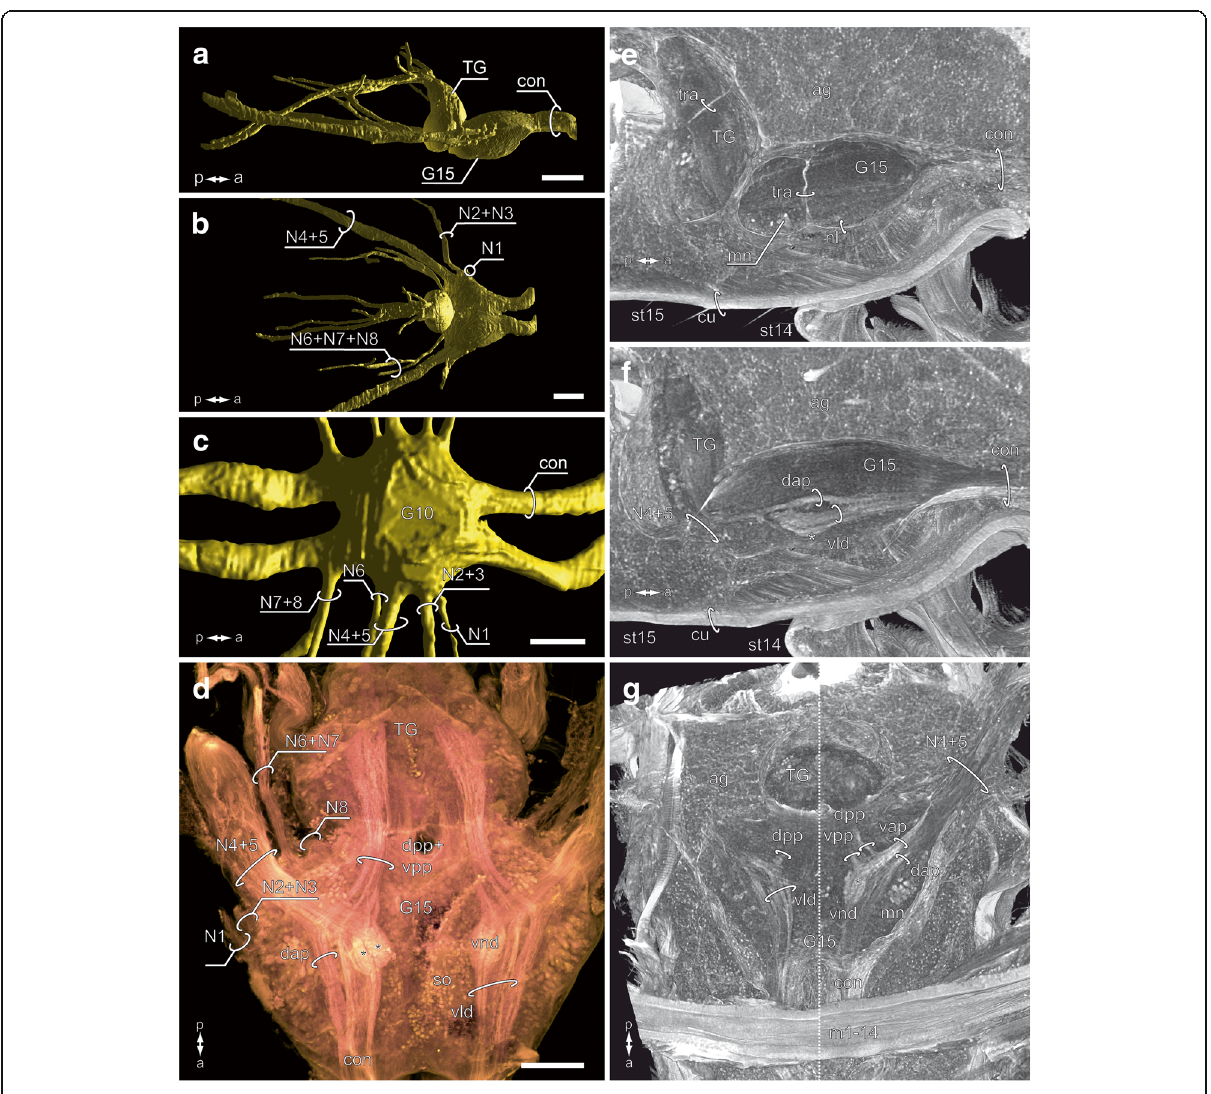
Fig. 8 Morphology and anatomy of the ultimate leg-associated ganglion (G15). a , b 3D reconstruction of G15, the terminal ganglion, and associated nerves. MicroCT analysis, lateral and dorsal views. Note the posteriad directed nerves. Scale bars 200 μ m. c 3D reconstruction of walking leg-associated ganglion 10, based on microCT analysis, dorsal view (modified after [18]). Note the laterad projecting nerves. Scale bar 200 μ m. d Autofluorescence preparation of G15 and terminal ganglion. cLSM maximum projection of the ventral part of the ganglion. Within the ganglion, leg afferents from nerves N4 and N5 comprise prominent anteriad projections, including the glomeruli of the ventral neuropilar domain (asterisks) and the ventral lamellate domain (vld). Note that projections proceed into the anterior connectives. In addition, posteriad projections (dpp and vpp) proceed into the terminal ganglion. Scale bar 100 μ m. e – g Volume visualizations of posterior vnc with G15 and terminal ganglion based on microCT analysis. e and f sagittal view, g horizontal view. The entire posterior vnc is embedded in the tissue of accessory glands (ag) of the male reproductive system. e Tracheal ducts (tra) penetrate TG and G15. f Leg afferents of N4 + N5 proceed anteriad into the ganglion comprising a dorsal anteriad projection (dap), a ventral lamellate domain (vld), as well as the ventral neuropilar domain (asterisk). g Different virtual, horizontal sections showing afferents from N4 + N5 splitting into a dorsal and ventral anteriad projection (dap and vap, right half), the ventral lamellate domain (vld, left half), and the ventral neuropilar domain (vnd, right half). Dorsal and ventral posteriad projections (dpp and vpp) target the terminal ganglion. Note the highly contrasted somata of motoneurons (mn, right half). Abbreviations: ag accessory glands, con connective, cu cuticle, dap dorsal anteriad projection, dpp dorsal posteriad projection, G ganglion of the vnc, m1 – 14 transversal muscle 1 of trunk segment 14, mn motoneurons, N nerve, nl neurilemma, so somata, st sternite, TG terminal ganglion, tra tracheal ducts, vap ventral anteriad projection, vld ventral lamellate domain, vnd ventral neuropilar domain, vpp ventral posteriad located along the paramedian plane of the ganglion, is rela- vpp; Figs. 8d, g; 9a – d). The majority of neurites, however, tively thin and proceeds anteriad without further arboriza- proceed anteriad and target different areas of the neuropil tions (Figs. 8d – g; 9d). The ventral anteriad projection (vap) (Figs. 8d – g; 9a – d). The dorsal anteriad projection (dap),